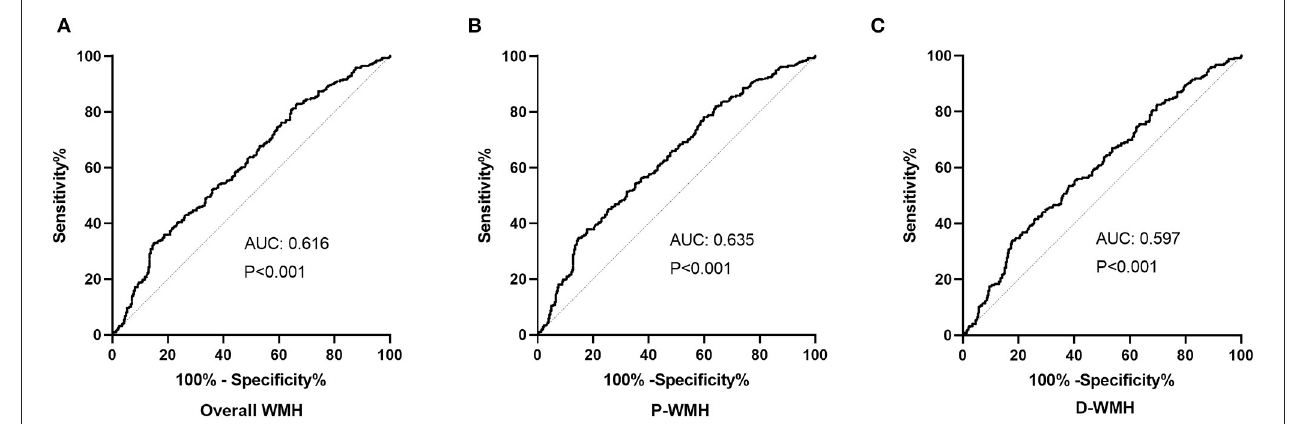
FIGURE 3 | Receiver operating characteristic analysis of PAGln according to the severity of WMH. (A) The AUC was 0.616, and the optimal PAGln level cut-off value was 3.348 µ mol/L for overall WMH. (B) The AUC was 0.635, and the optimal PAGln level cut-off value was 3.075 µ mol/L for P-WMH. (C) The AUC was 0.597, and the optimal PAGln level cut-off value was 3.341 µ mol/L for D-WMH. ROC, receiver operating characteristic curve; PAGln, phenylacetylglutamine; WMH, white matter hyperintensity; P-WMH, periventricular white matter hyperintensity; D-WMH, deep white matter hyperintensity; AUC, area under the